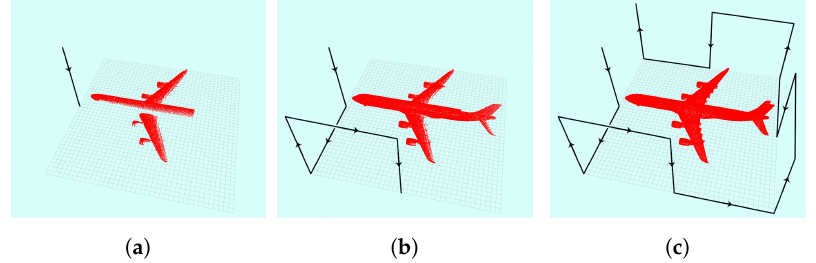
Figure 4. Profiling process following structure bounded box. The cumulative profile and path are shown after executing: ( a ) one waypoint; ( b ) three waypoints; and ( c ) eight